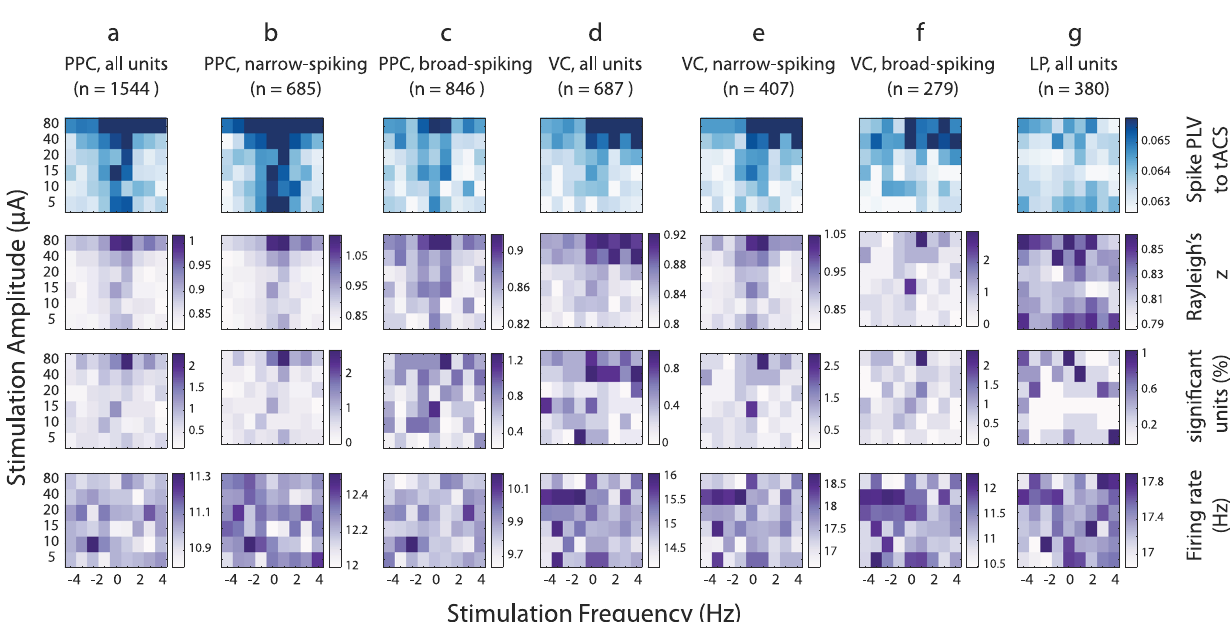
Fig. 5 Transcranial alternating current stimulation engages cortical alpha oscillations at the level of individual neurons. Synchronization maps (blue) and corresponding Rayleigh ’ s z -score (purple, second row), percentage of units with signi fi cant phase-locking value (purple, third row), and fi ring rate maps (purple, bottom row) as a function of stimulation parameters for PPC ( a – c ), VC ( d – f ), and LP ( g ). The synchronization maps show phase-locking between individual spikes and tACS wave as measured by phase-locking value (PLV) averaged across units. The horizontal axis indicates the distance (in Hz) from individual alpha frequency, and the vertical axis shows the stimulation amplitude. a (top two rows) tACS entrains PPC units as indicated by the Arnold tongue centered at the individual endogenous alpha frequency. b , c (top two rows) Narrow-spiking units in PPC show stronger phase-locking to tACS when compared to their broad-spiking counterparts. d – f (top two rows) VC units are phase-locked to tACS, but the area of entrainment is asymmetric and favors stimulation at frequencies above the endogenous peak frequency. g (top two rows) The map for LP units does not show prominent synchronization. a – g (third row) Only a small percent of units (<2%) show signi fi cant modulation of spike phases as measured by Rayleigh ’ s test. a – g (bottom row) The random pattern of fi ring rate maps for all regions/unit types indicates that tACS did not modulate the fi ring rate of target